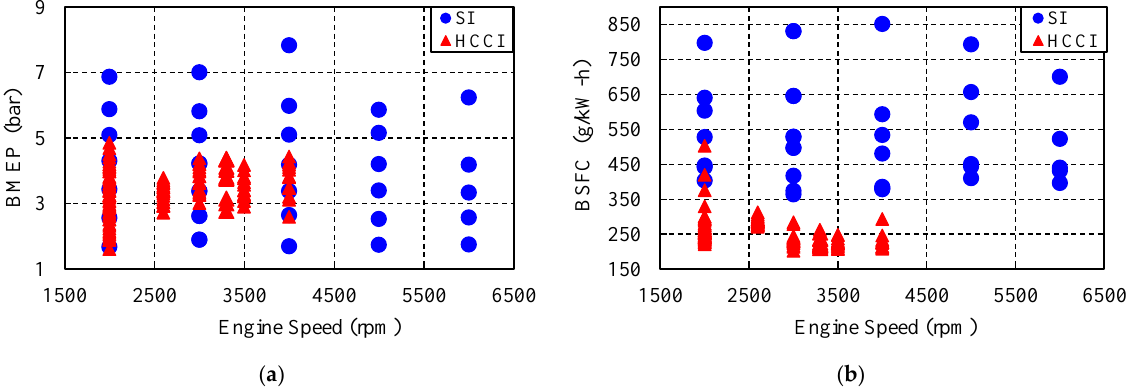
Figure 20. Comparison of engine characteristics between proposed HCCI and original SI engine: ( a ) BMEP; ( b ) BSFC.